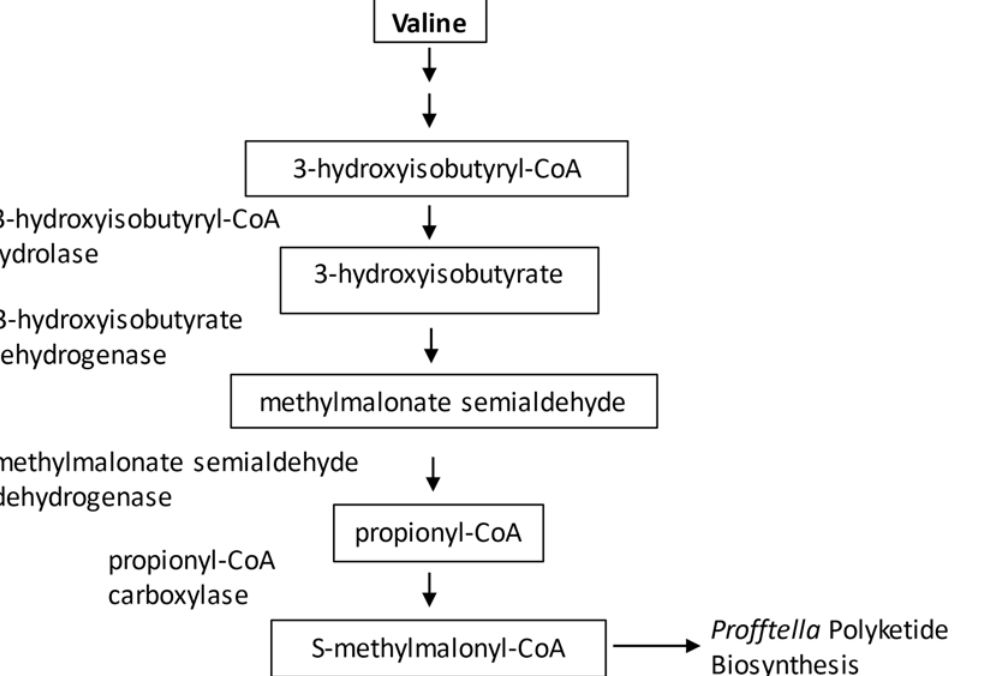
Fig 6. Metabolic interplay between D . citri and Profftella . Proposed model of shared metabolic pathway wherein S-methylmalonyl-CoA from D . citri valine catabolism is provisioned to Profftella for polyketide biosynthesis.